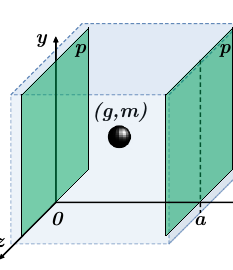
Figure 1 . A point particle with mass m and charge g in the presence of two identical and perfectly reflecting parallel planes p placed at x = 0 and x = a , confining the field modes of a massless quantum scalar